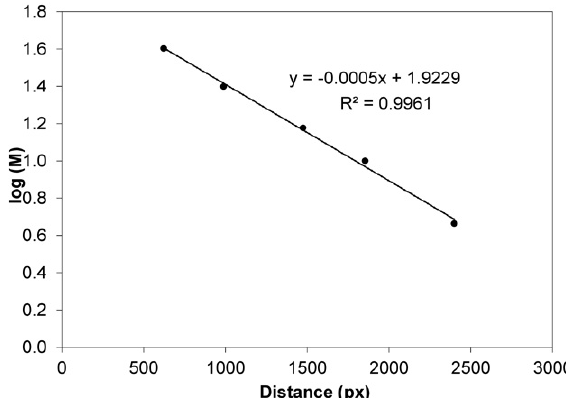
Figure 3. Standard curve of molecular weight markers using SDS- PAGE electrophoresis for molecular weight estimation of keratin samples, which are obtained by hydrothermal degradation of waste wool at 180